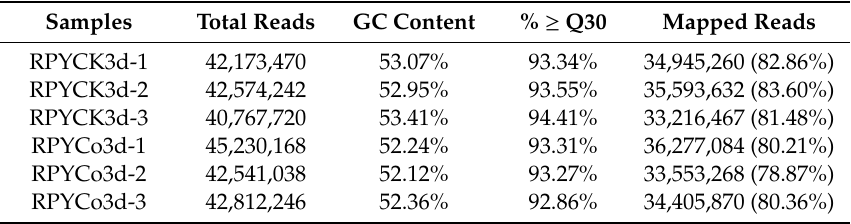
Figure 1. ( A ) Heatmap of Pearson’s correlation between six samples. The value in the heatmap represents the Pearson’s correlation coefficient between the two samples, and the color from pink to blue represents the correlation from weak to strong. ( B ) Volcano Plot of all differentially expressed genes (DEGs). Black dots represent non DEGs, red dots represent upregulated DEGs, and green dots represent downregulated DEGs. ( C ) Heatmap of the expression level of 4779 DEGs. Heatmap is based on FPKM values of all samples. The color from green to red represents the gene expression level from low to high. Table 1. Summary information of sequencing data and mapped